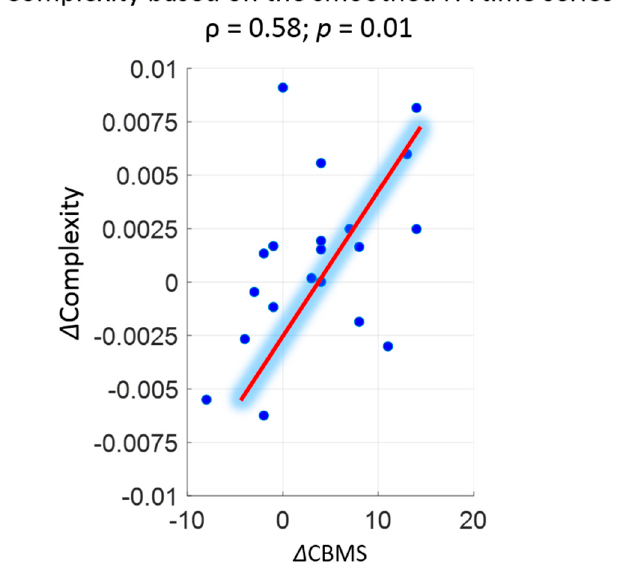
Figure 4. Association between complexity change and CBMS score change after smoothing PA time series.